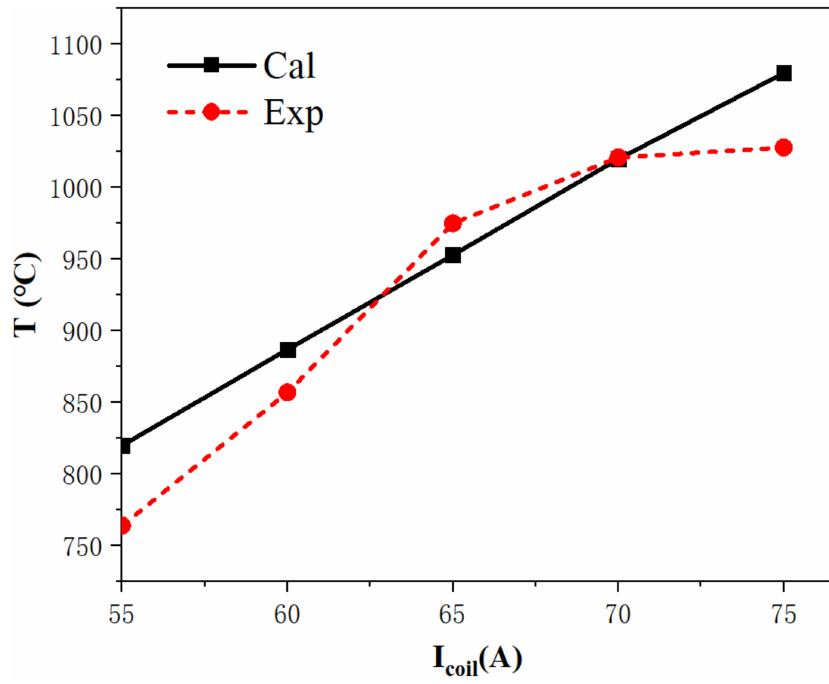
Figure 4. The calculated and experimental temperature of point